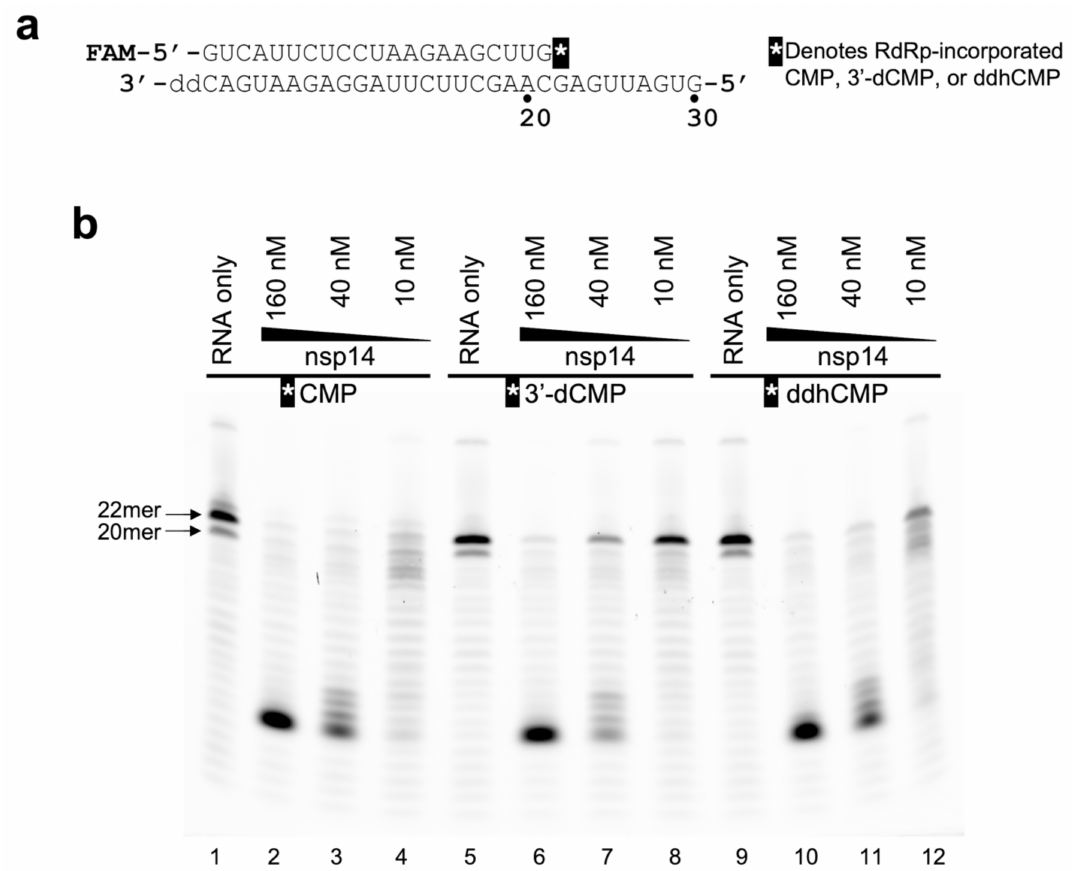
Figure 4. Degradation of 3 (cid:48) -dCMP or ddhCMP-terminated RNA strand by SARS-CoV-2 nsp14– nsp10 complex. ( a ) Sequences of the 22-nt RNA strand with CMP, 3 (cid:48) -dCMP, or ddhCMP at the 3 (cid:48) -terminus (stalled after the incorporation of CTP, 3 (cid:48) -dCTP, or ddhCTP by RdRp, respectively) and the 3 (cid:48) -protected 30-nt RNA template. ( b ) Degradation of the 22-nt RNA with CMP (lanes 1–4), 3 (cid:48) -dCMP (lanes 5–8), or ddhCMP (lanes 9–12) at the 3 (cid:48) -terminus by the SARS-CoV-2 nsp14–nsp10 complex at indicated concentrations. A representative gel result for 3 independent experiments is